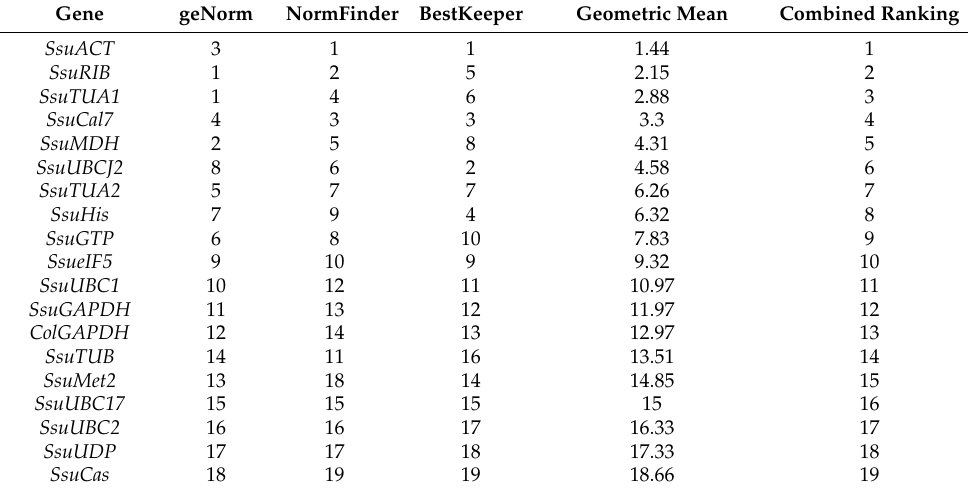
Table 4. Comprehensive evaluation of stability of candidate reference genes.